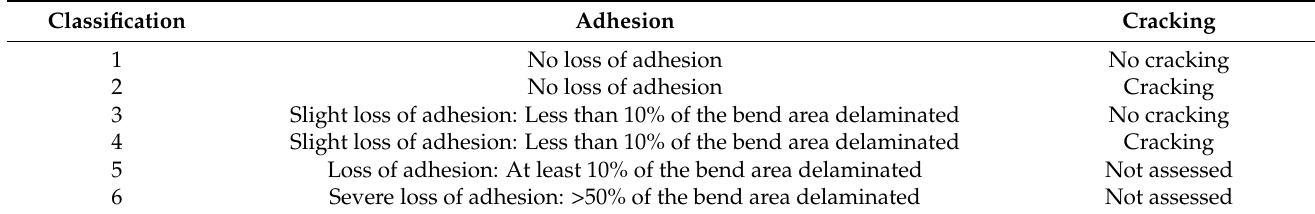
Table 2. Internal ranking for the T-bend